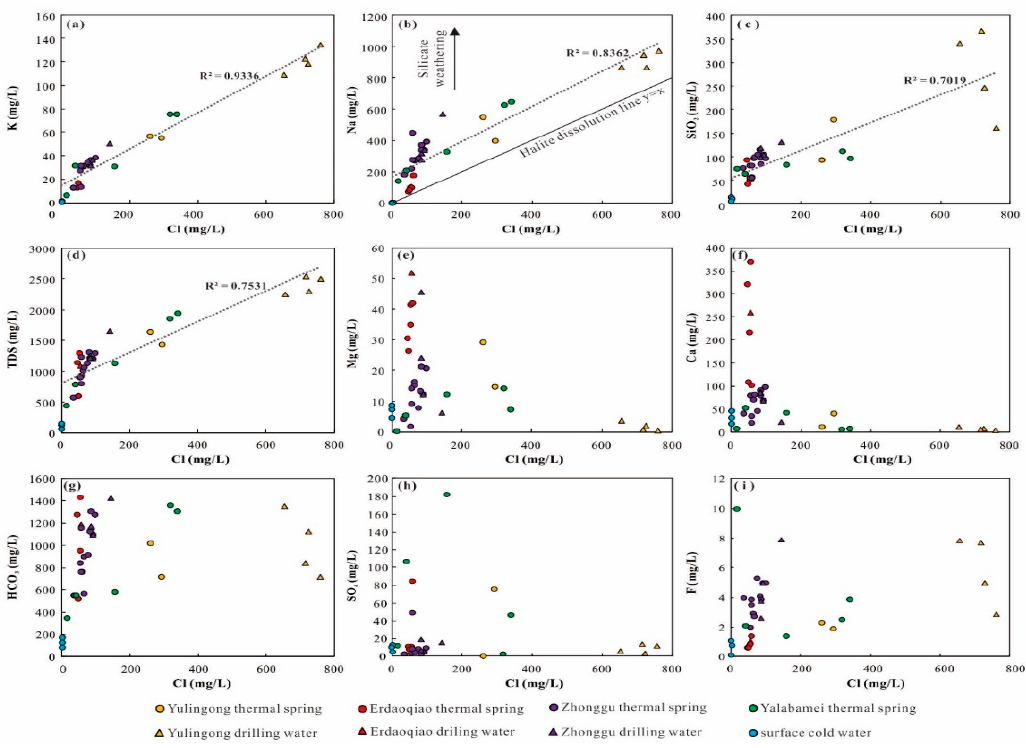
Figure 4. The plots of Cl against ( a ) K, ( b ) Na, ( c ) SiO 2 , ( d ) TDS, ( e ) Mg, ( f ) Ca, ( g ) HCO 3 , ( h ) SO 4 , and ( i )